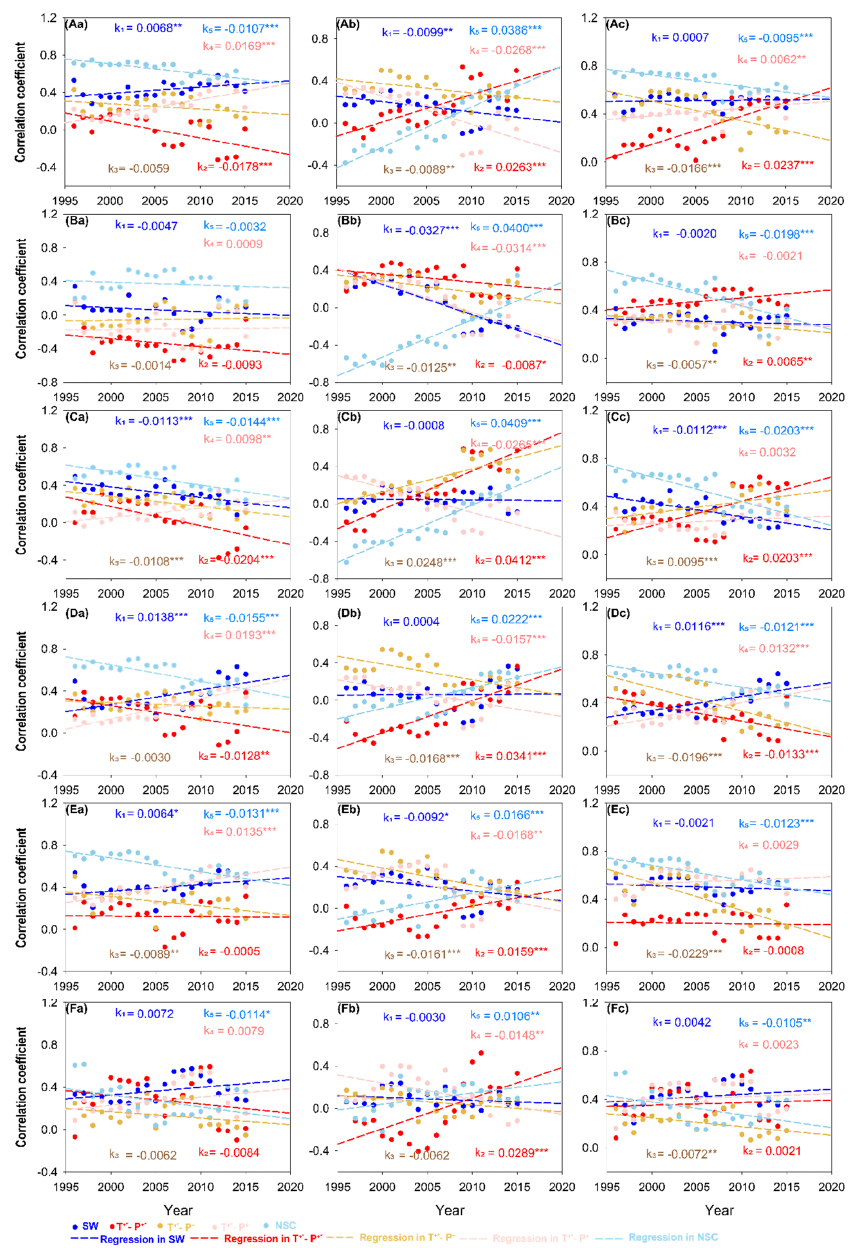
Figure 5. Change trend of the correlation coefficient between NDVI and temperature and precipitation over 15 years of sliding. Capital letters ( A – F ) represent Mean, P 100 , P 75 , P 50 , P 25 and P 5 , respectively. Small letters ( a – c ) refer to the partial correlation coefficient and the multiple correlation coefficient between NDVI and temperature and precipitation. Numbers 1–5, respectively, represent the SW, T +* -P +* , T +* -P − , T +* -P + and NSC.1–5 respectively represent the SW, T +* -P +* , T +* -P − , T +* -P + and NSC. “*”, “**”, and “***” indicate the significance of p < 0.1, p < 0.05, and p < 0.01, respectively.